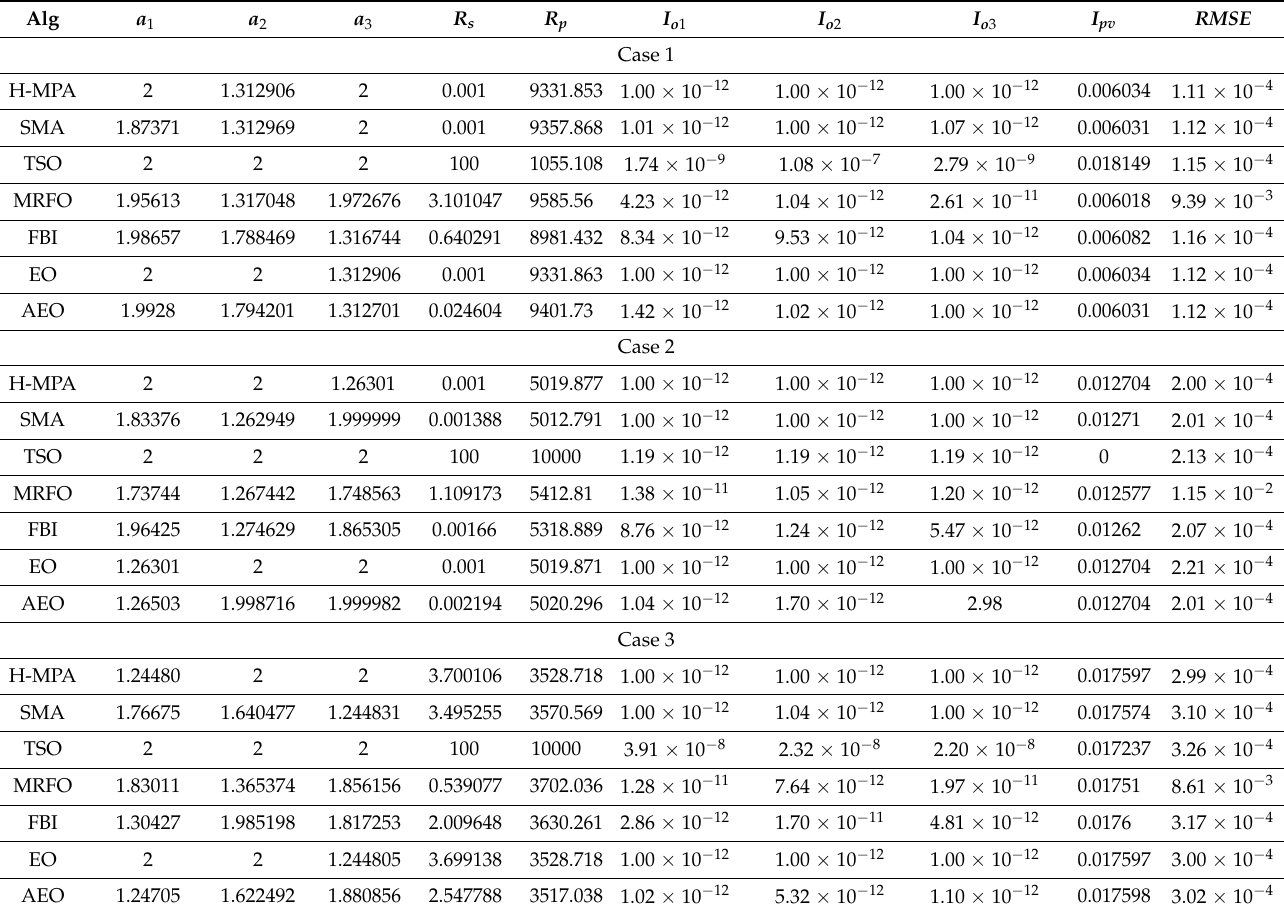
Table 3. The estimated parameters for the studied cases with the related fitness